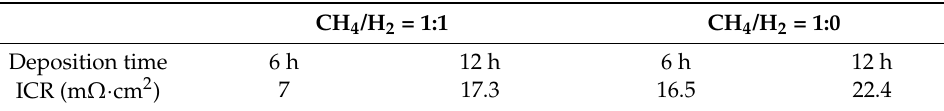
Table 3. ICR of DLC films using different conditions.